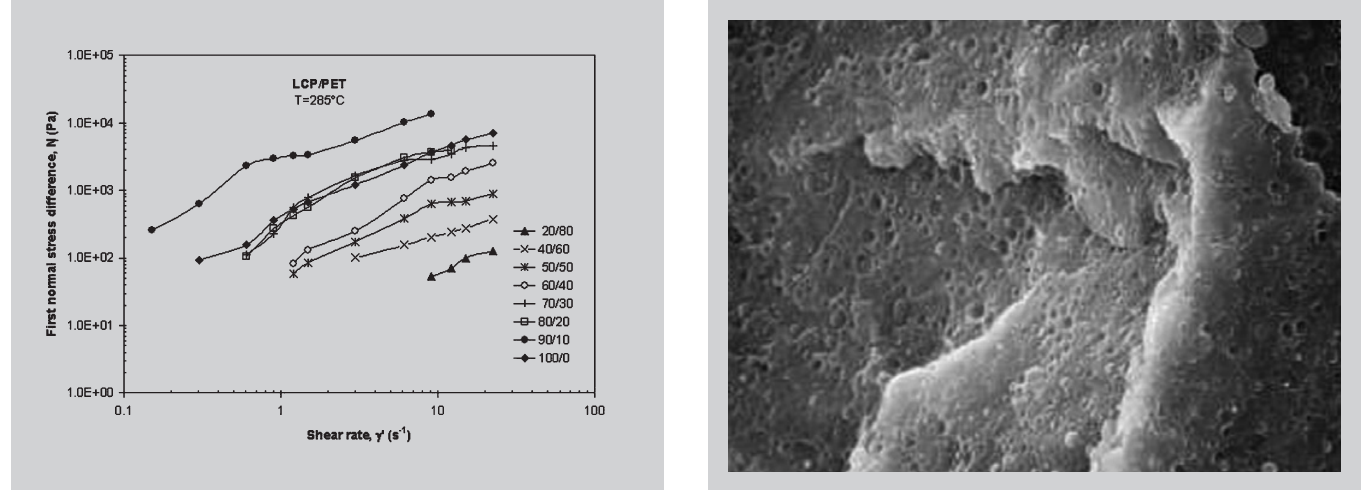
Figure 11 (left): Variation in first normal stress difference,N LCP/PET blend with shear rate at 285°C. Figure 12: SEM micrograph of 10 vol% LCP distributed in PET